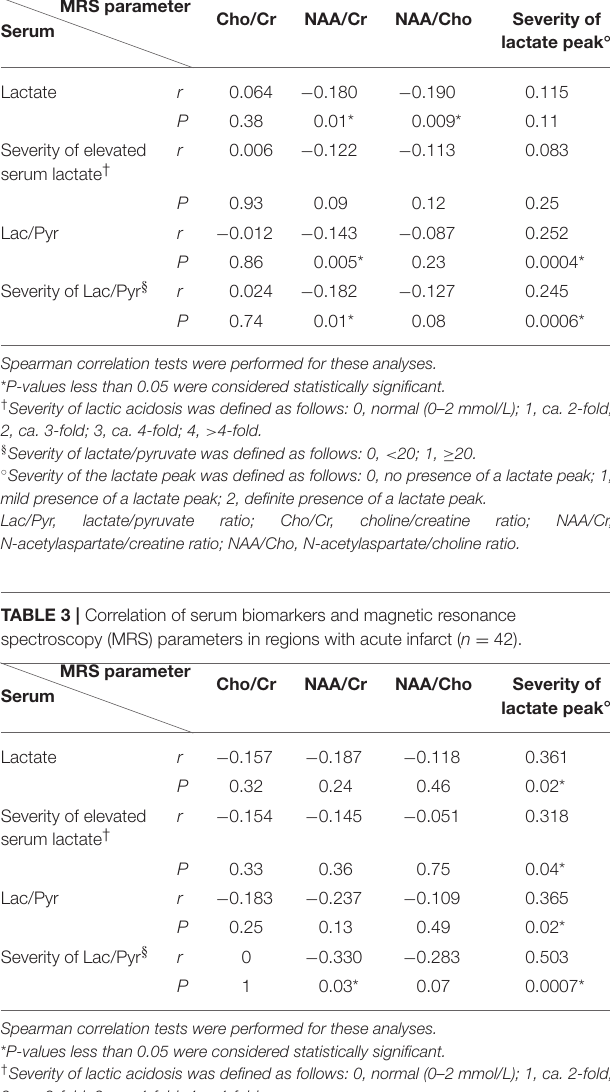
spectroscopy (MRS) parameters in total voxels ( n = 191). MRS parameter Serum